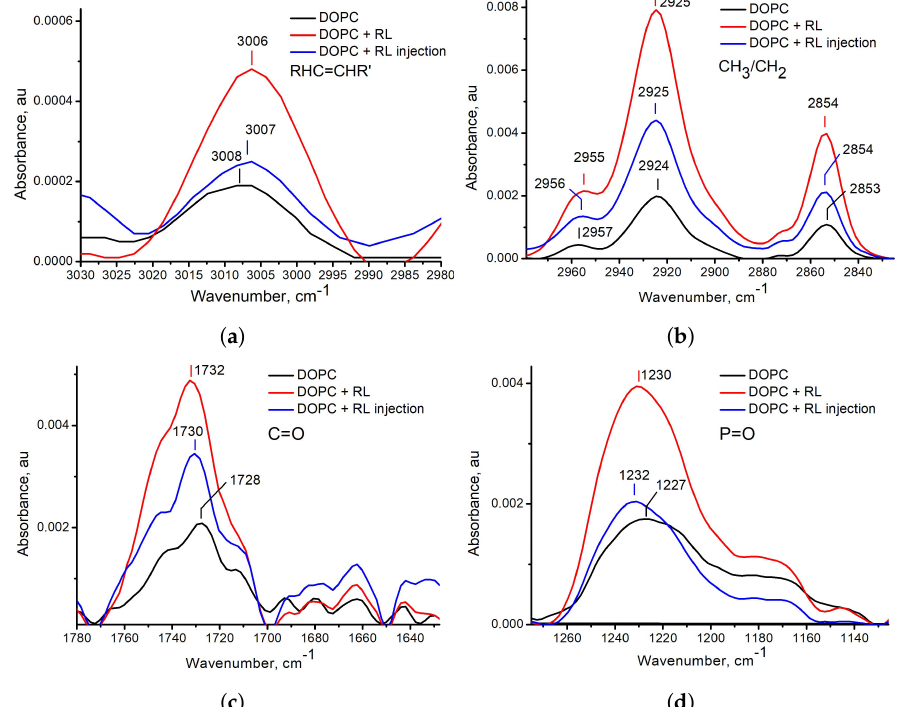
Figure 4. ATR − FTIR spectra of liposomes from DOPC without rhamnolipids (black solid line), liposomes prepared from a mixture of DOPC and rhamnolipids (red solid line), and liposomes from DOPC with an rhamnolipids injection (blue solid line) in the region of hydrogen vibrations at a double carbon bond in the cis configuration ( a ), vibrations in CH 2 and CH 3 groups ( b ), vibrations of C=O ( c ) and P=O ( d )